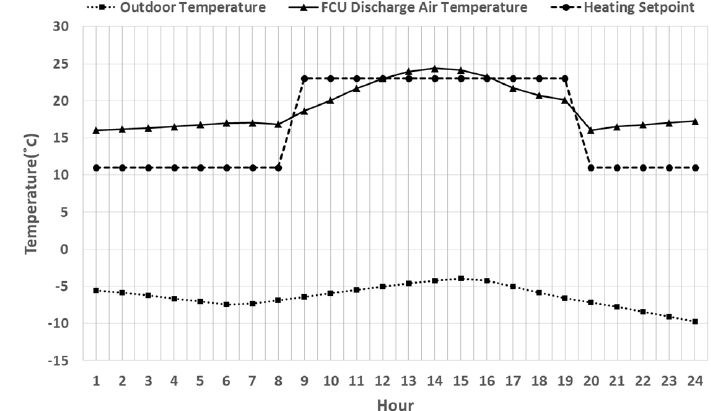
Figure 6. FCU discharge air and outdoor air temperature